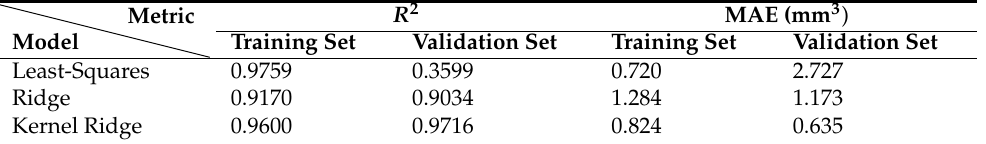
Table 3. Performance of regression